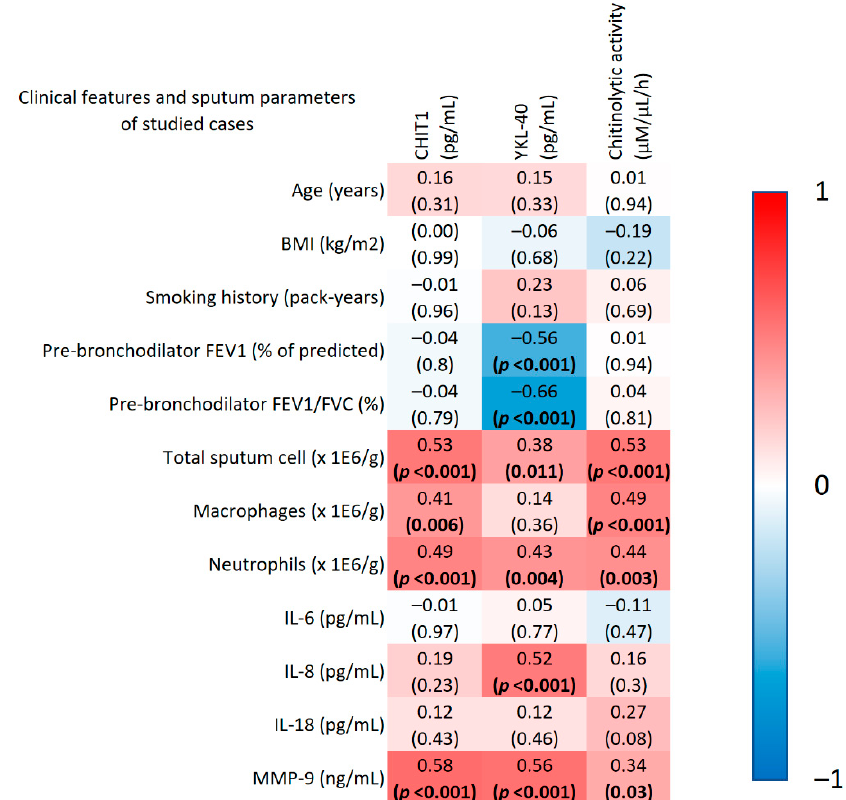
Figure 2. Correlation heatmap between selected clinical and sputum parameters and sputum chitinase levels in the entire study group (COPD patients and controls), expressed as correlation coefficient (r). The heatmap shows the correlation between clinical and sputum parameters (rows) and IS CHIT1 and YKL-40 levels and chitinolytic activity (columns). The colours of the heatmap correspond to the r-value ( − 1 to +1). The upper row in each square of the table denotes the r-value of the Spearman (cid:48) s rank correlation and the lower row denotes its p -value. Abbreviations: BMI-body mass index; CHIT1-chitotriosidase; FEV1-forced expiratory volume in the first second; FVC-forced vital capacity; IL-interleukin; MMP-9-matrix metalloproteinase 9; YKL-40-chitinase-3-like protein 1. Bolded values show statistical significance ( p <